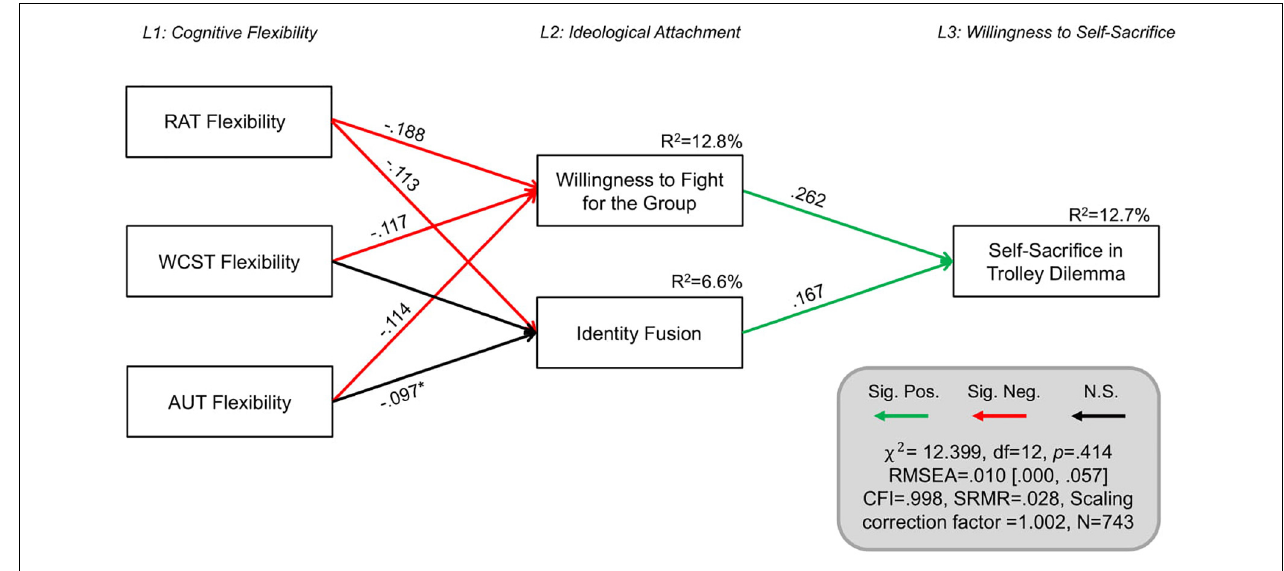
FIGURE 4 | Structural equation model predicting willingness to sacrifice oneself in the trolley problem All parameters shown are fully standardized. For unstandardized estimates, SEs, and confidence intervals, see Supplementary Data . Significant parameter estimates are shown in red and green bolded lines. Residual covariances between variables on the same level are allowed, but not shown for simplicity. Model controls for demographic variables (age, gender, educational attainment). Significance level was p < 0.05. ∗ p = 0.062. L1, level 1; L2, level 2; and L3, level 3. Figure design was inspired by Kievit et al.